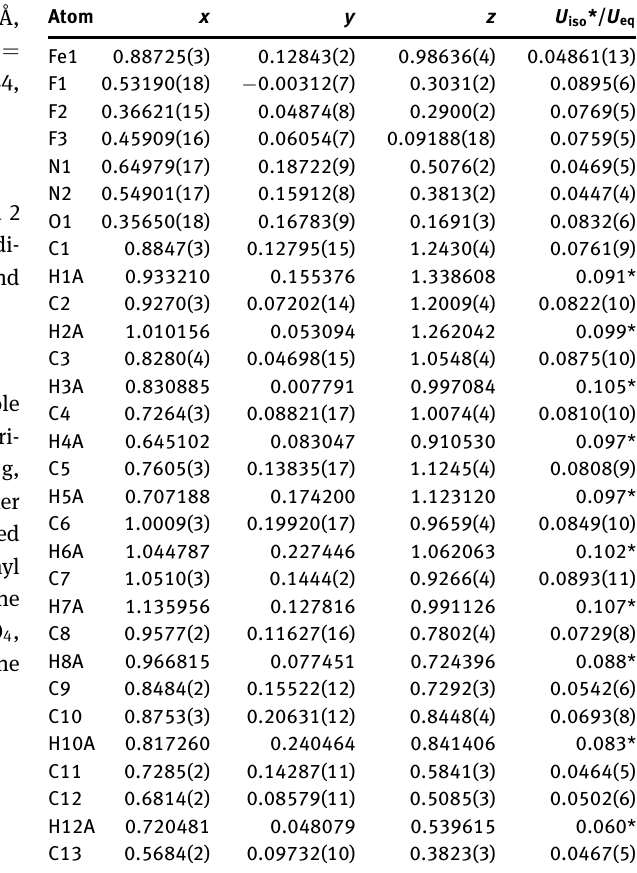
Table 2: Fractional atomic coordinates and isotropic or equivalent isotropic displacement parameters (Å 2